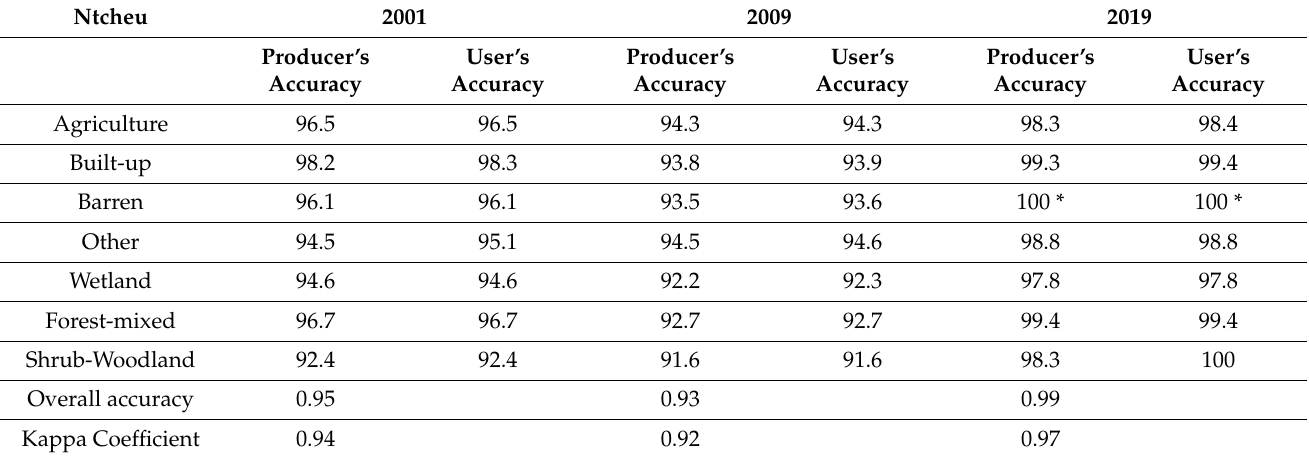
Table 7. Accuracy assessment summary for classified land-cover maps for Ntcheu district. (* 100 value accuracy has been rounded to one decimal